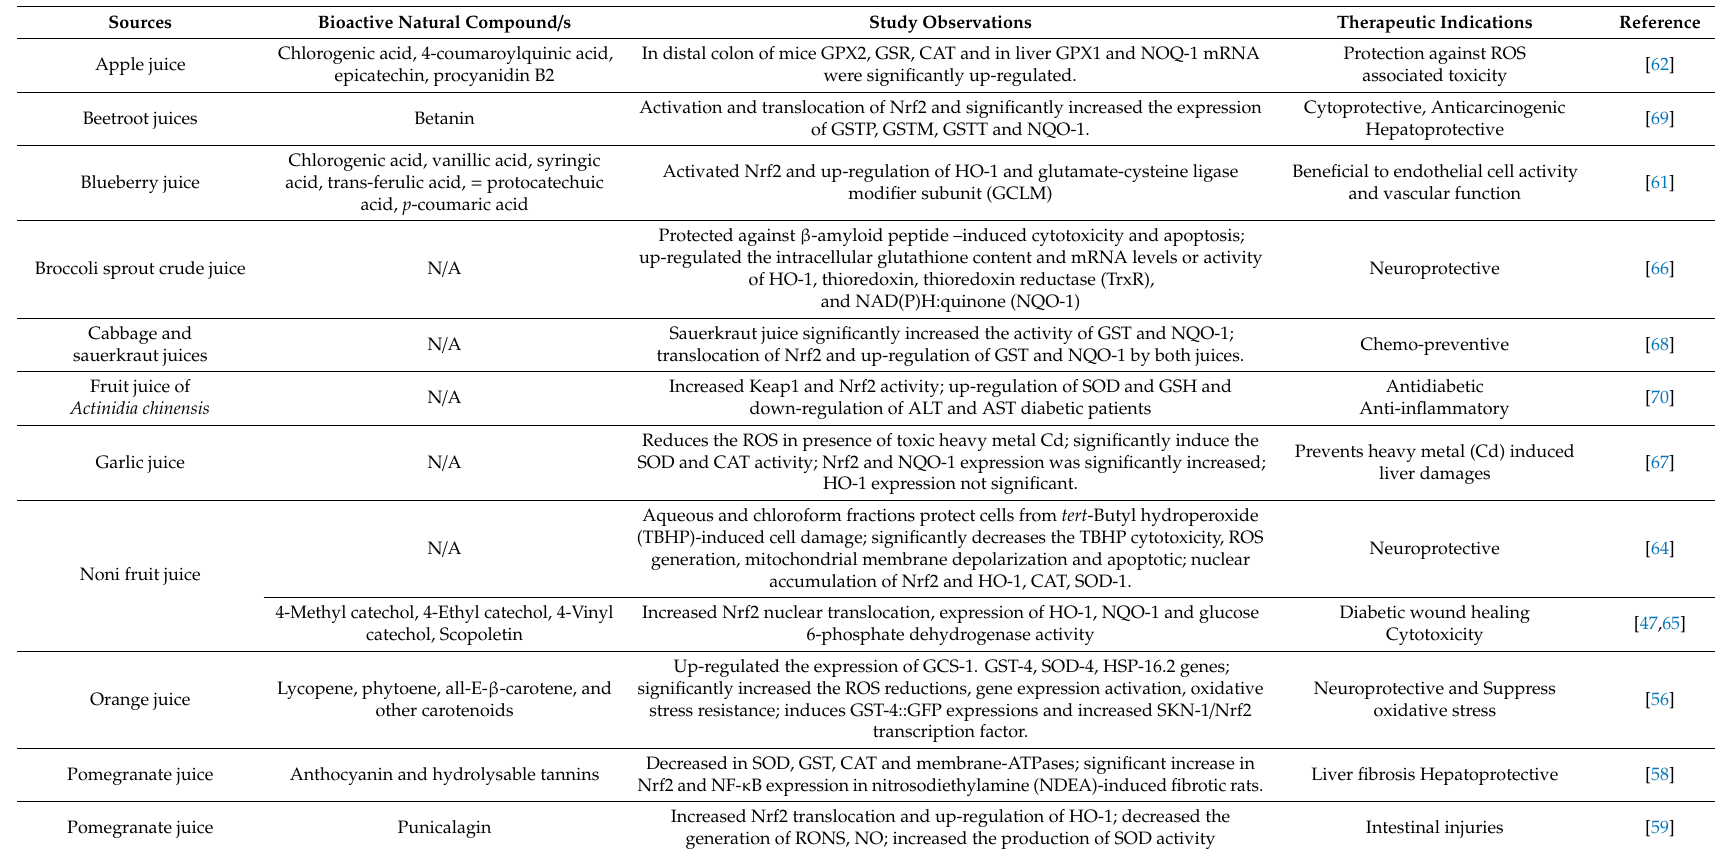
Table 2. List of phytochemicals present in fruit juices as Nrf2